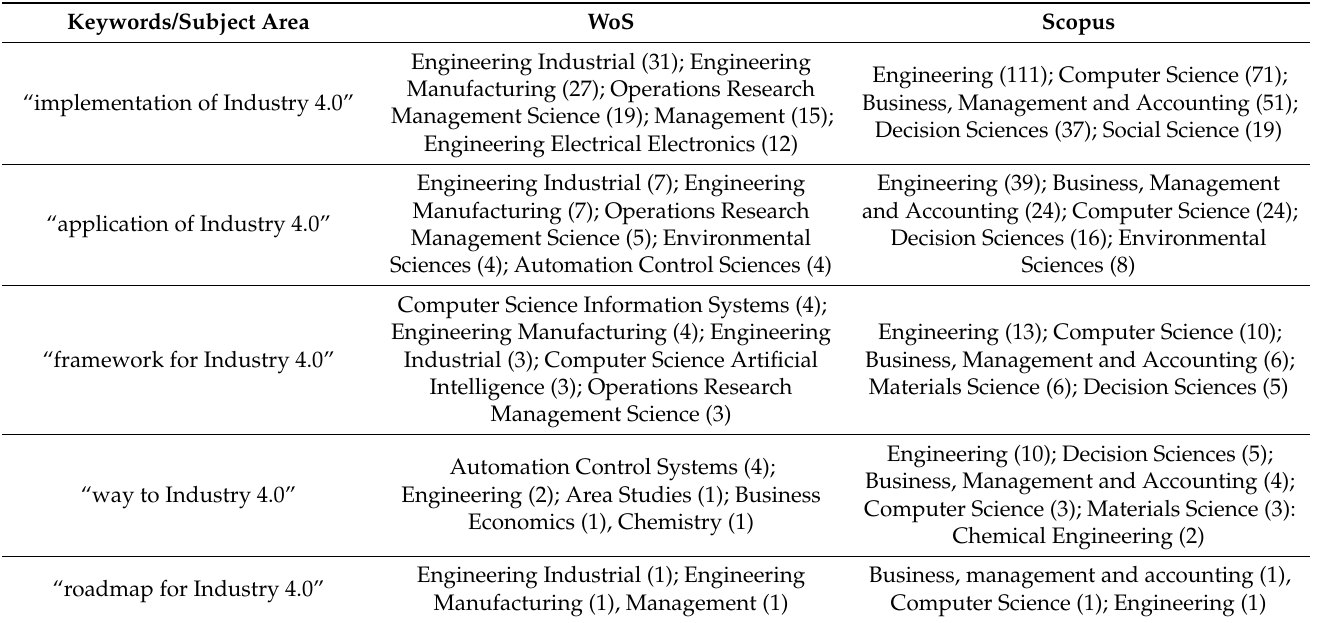
Table 5. Results of own literature review in the field: subject area or web of science